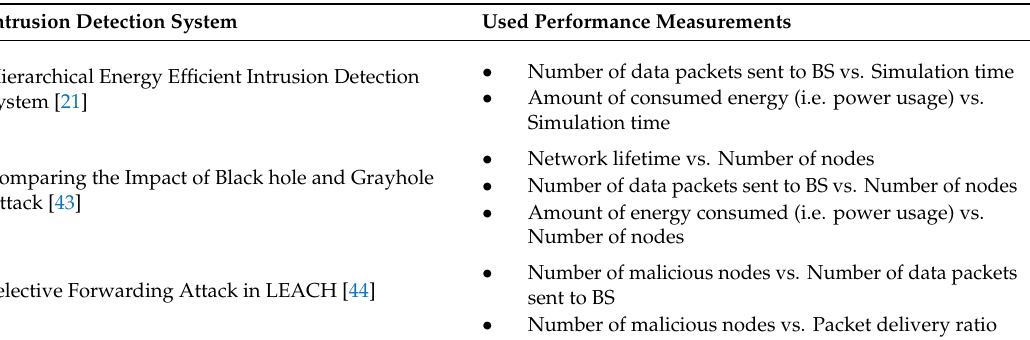
Table 1. Performance Measurements